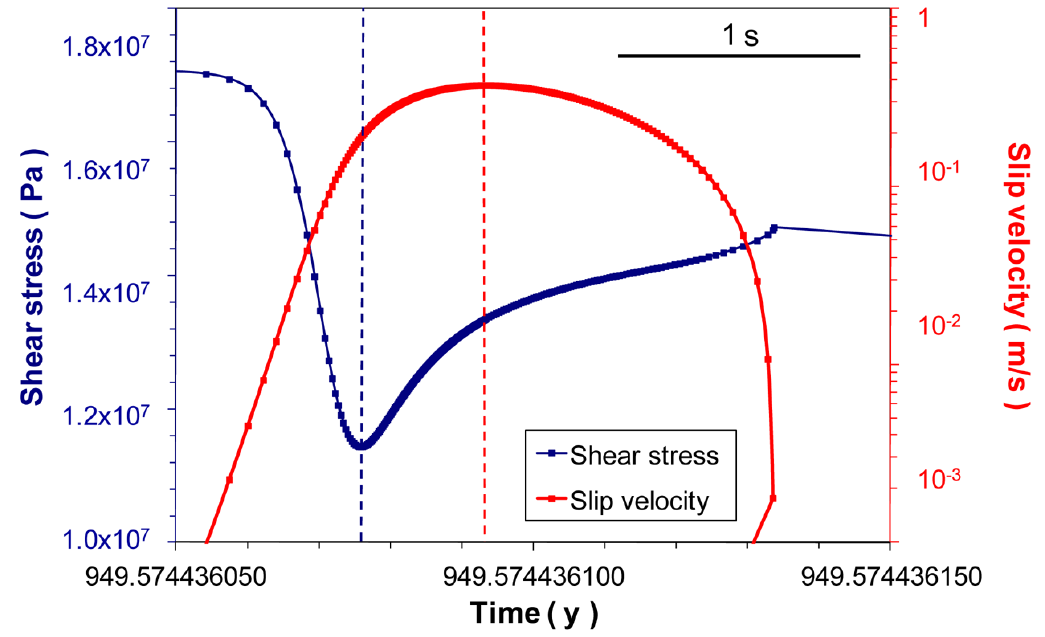
Figure 7. Superimposition of the slip velocity and the shear stress time histories, in the CH law case within a very narrow time window. The velocity peak is reached only a few instants after the shear stress minimum is